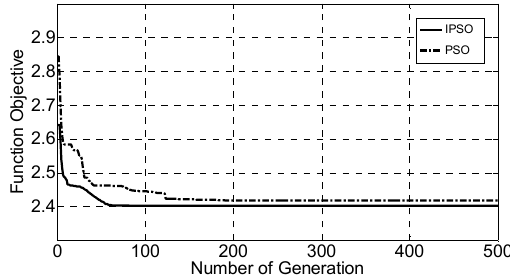
Figure 6. Convergence of the improved particle swarm optimization (IPSO) and PSO Algorithms.